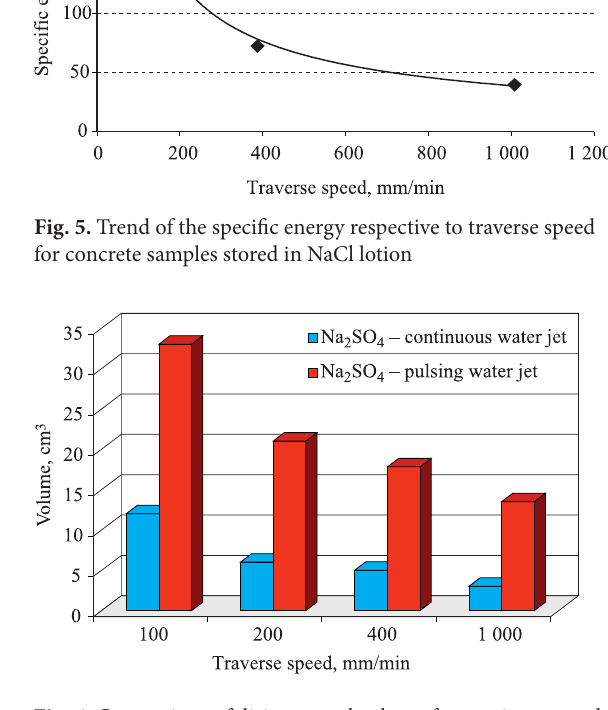
Fig. 6. Comparison of disintegrated volume for continuous and pulsing water jets on samples stored in Na 2 SO 4 lotion